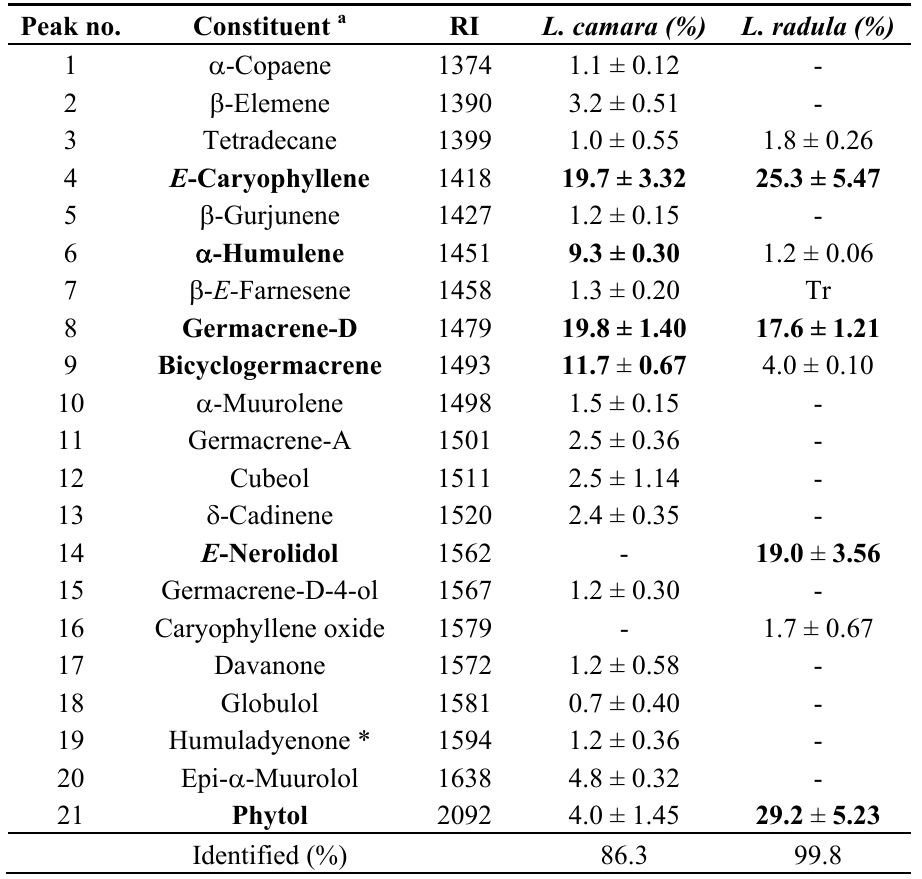
Table 1. Major components identified in the volatile oils of L. camara and L. radula . Peak